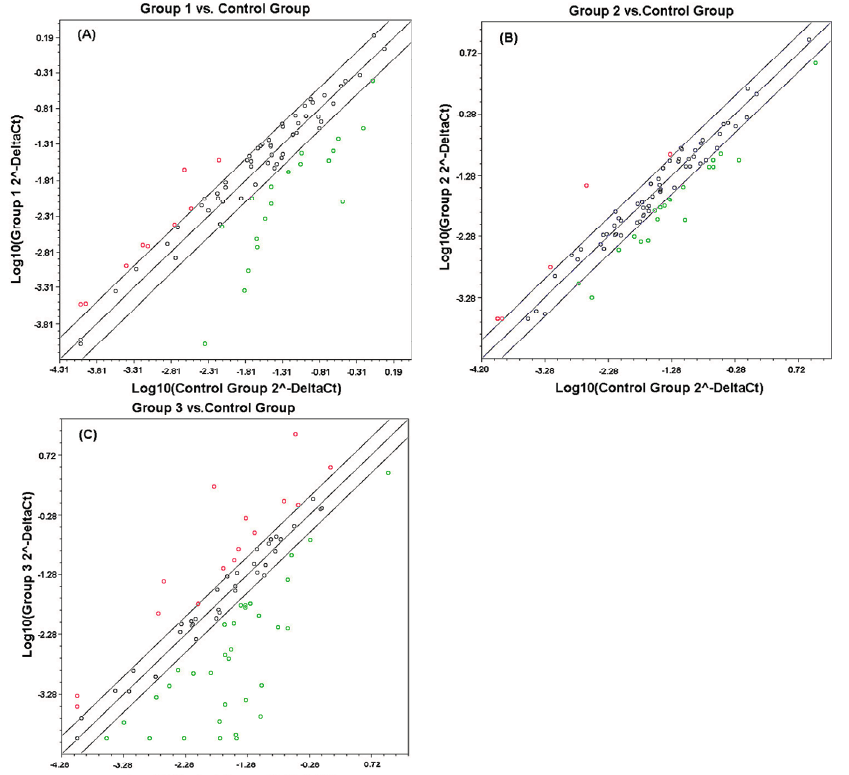
Figure 1. Scatter plot analysis representative of transcriptional profiles of human peripheral blood cells 24 h after exposure to different X-ray doses (( A – C ) 0.5, 3, and 10 Gy, respectively). This figure shows genes with increased (red color) or decreased (green color) expression after radiation compared with those of sham-irradiated cells; Genes with |fold regulation| < 2 were indicated in